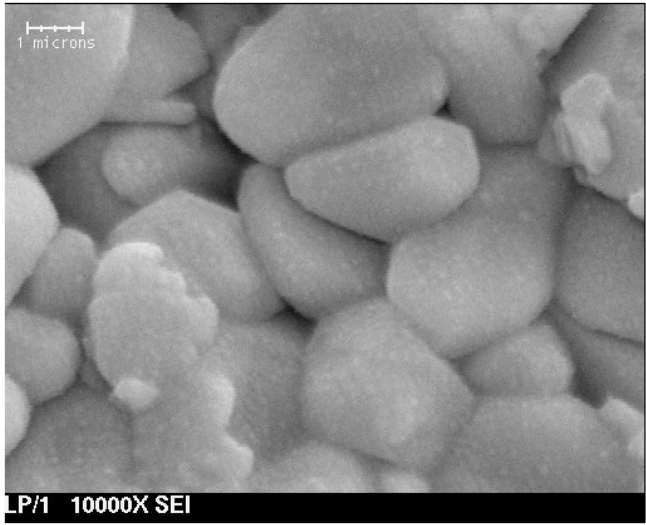
Figure 1. SEM image of the surface of the In 2,000.